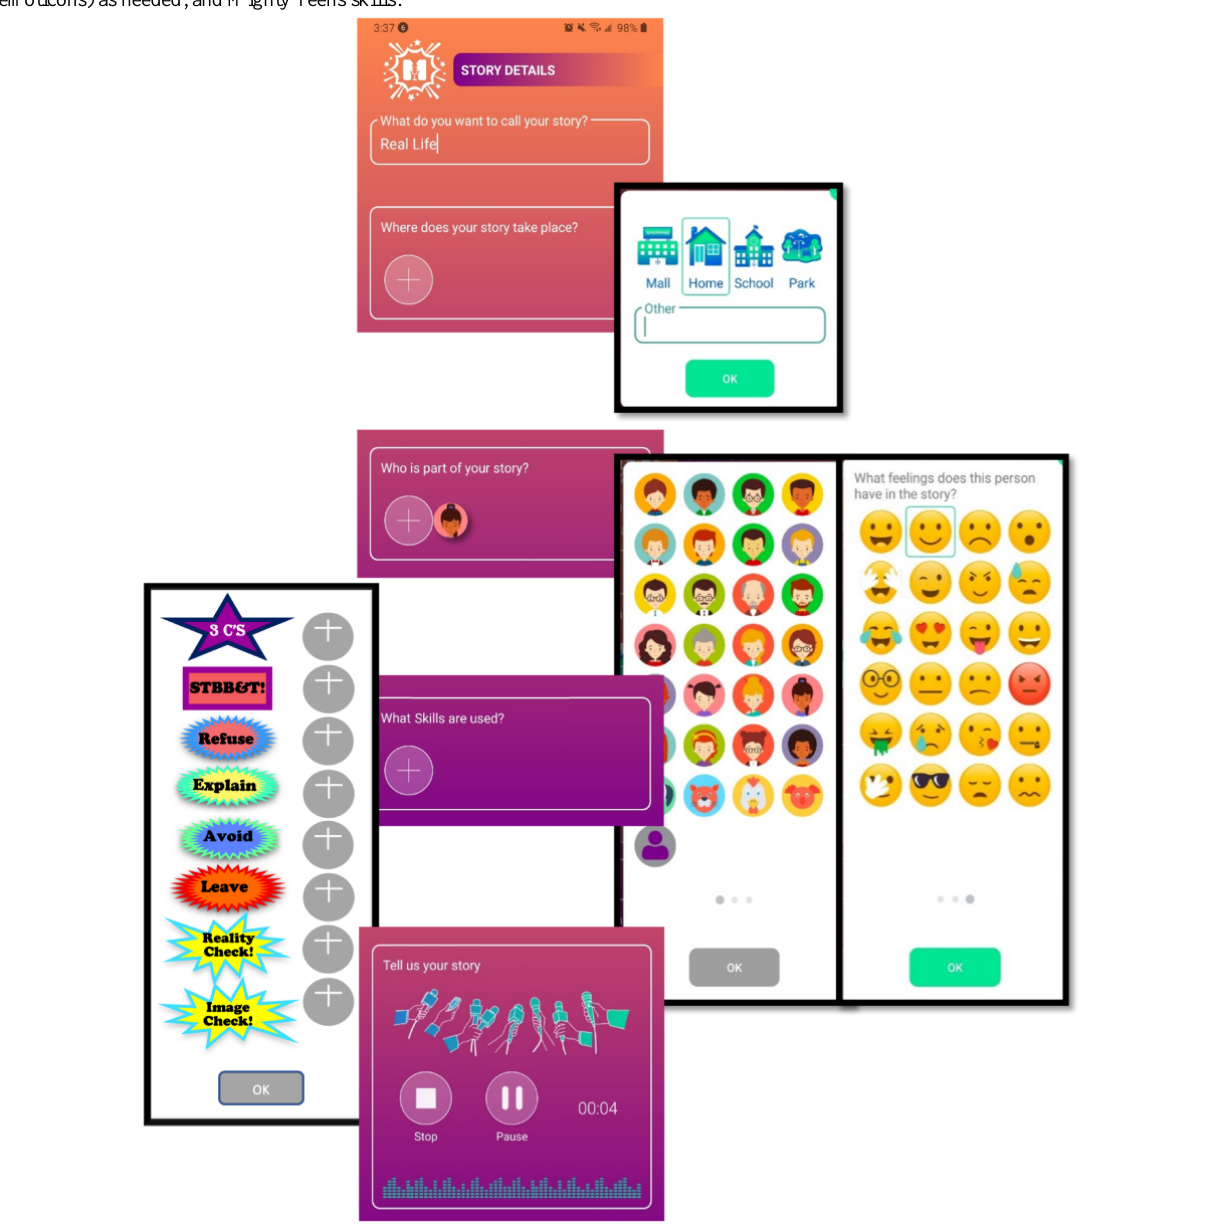
Figure 2. Mighty Teens app prototype story-creating screen with pop-ups allowing selection of places, characters with as many emotions (represented as emoticons) as needed, and Mighty Teens